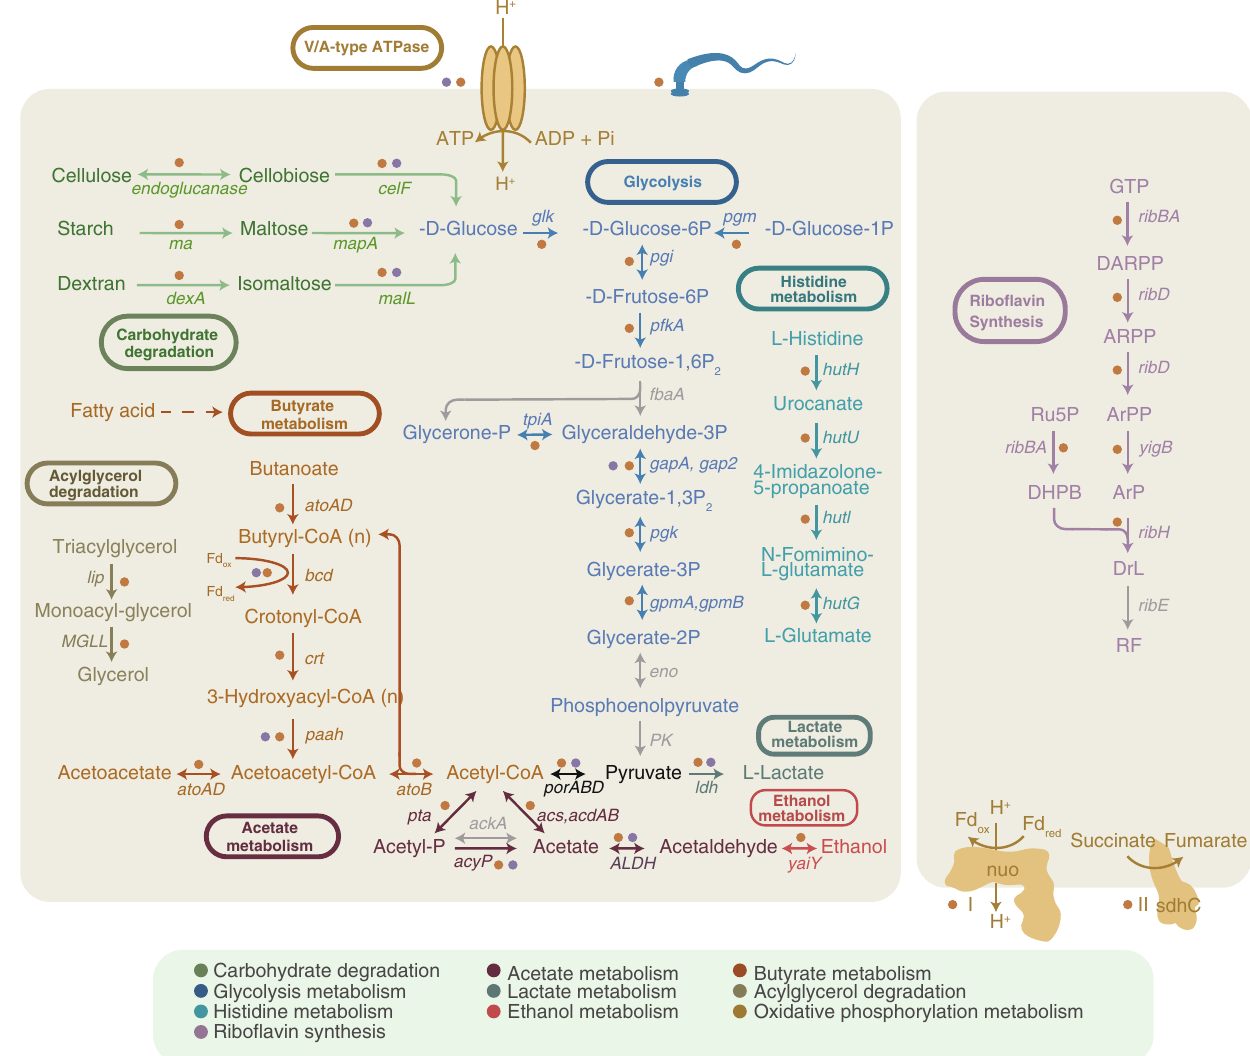
Fig. 5 Overview of the functional pro fi les depicting the pathways enriched in different diet periods with colors differentiating gibbon subjects (orange, A2; purple, B2). The diagrams showed metabolic pathways enriched during high-leaf (left) and during high-fruit (right). The colors of different solid lines corresponded to signi fi cantly differential metabolic pathways (Wilcoxon rank-sum test, and FDR-corrected p -value < 0.05). The genes with no signi fi cant difference between the two diets were marked with gray lines. The detailed information on the genes was summarized in Supplementary Table